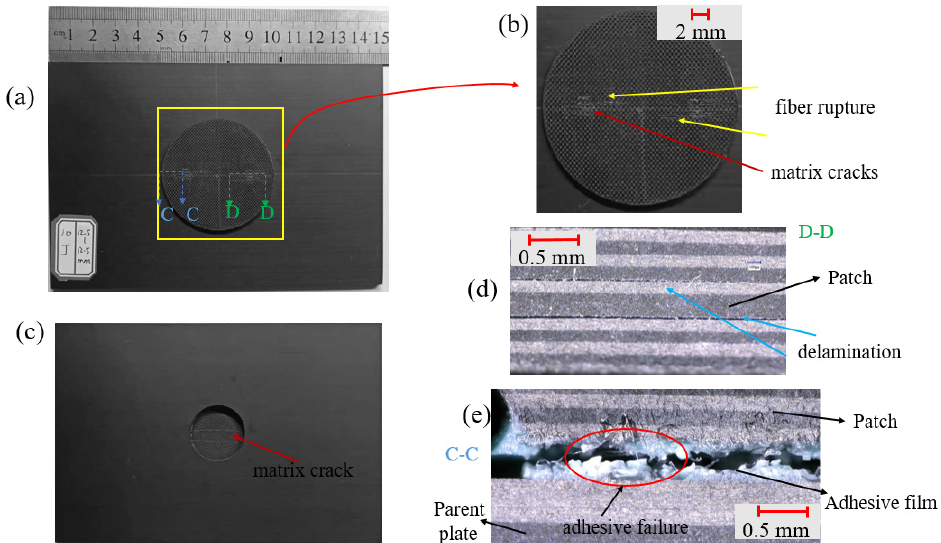
Figure 9. Micrographs of the patch-repaired specimen after the third impact at a distance of 12.5 mm: ( a ) the front part, ( b ) local figure of the patch, ( c ) the back part, ( d ) D-D section and ( e ) C-C section.